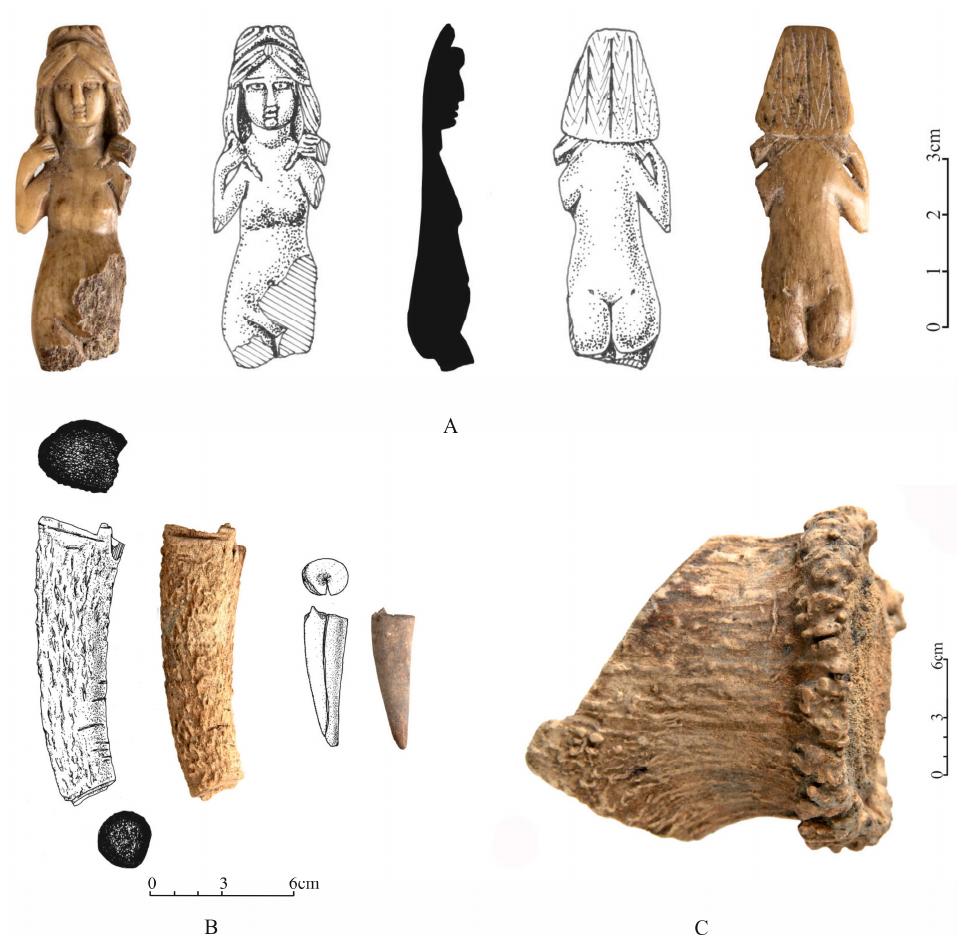
Figure 6. Red deer antler objects from Halmyris, Romania, 2014, extramuros area (4th–5th century AD). ( A ) Head of a distaff depicting Venus. ( B ) Sawn-off red deer antler tine and tip with saw marks. ( C ) Red deer antler with saw and knife marks on side surfaces.